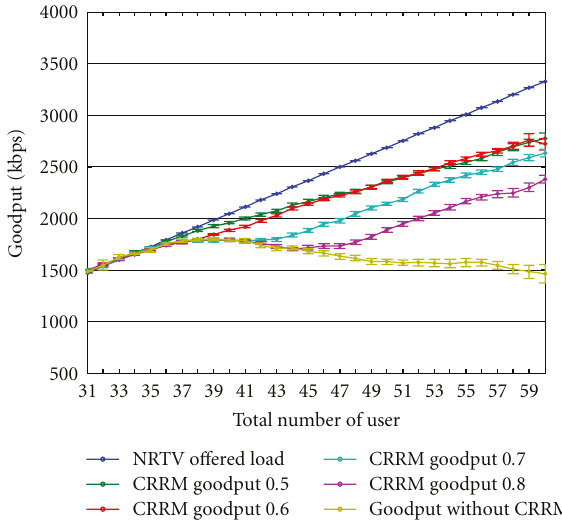
Figure 3: System total throughput with CRRM entity exploring the diversity gain for cell radius =